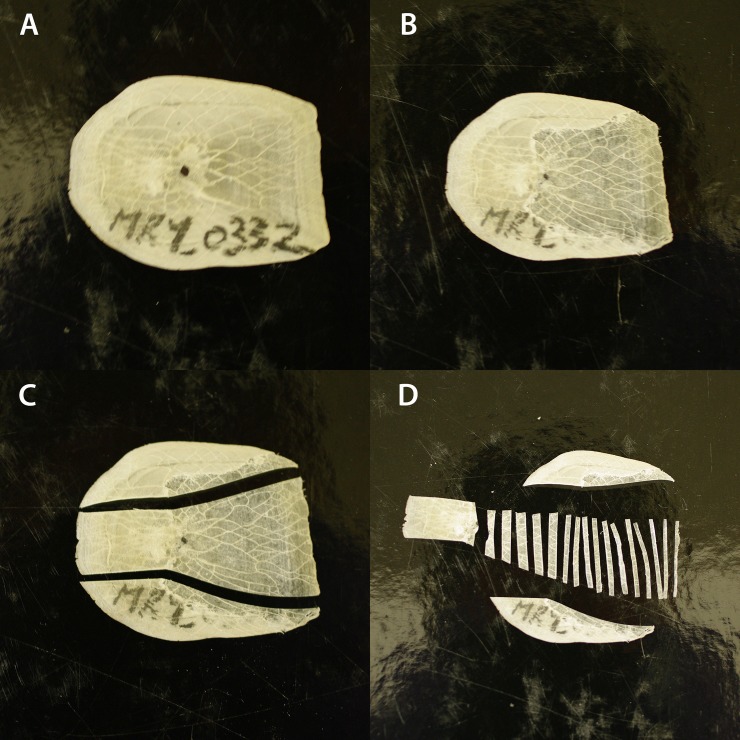
Scale sample collection.A) Dried and flat scale showing primordium as the black dot. B) Scale after removal of upper squamulae and lower elasmodin surfaces, cleaned area becomes transparent. C) Scale cut to prepare for sampling. D) F14C samples showing the first 11 samples removed in 1mm increments, then 2mm increments to the primordium.